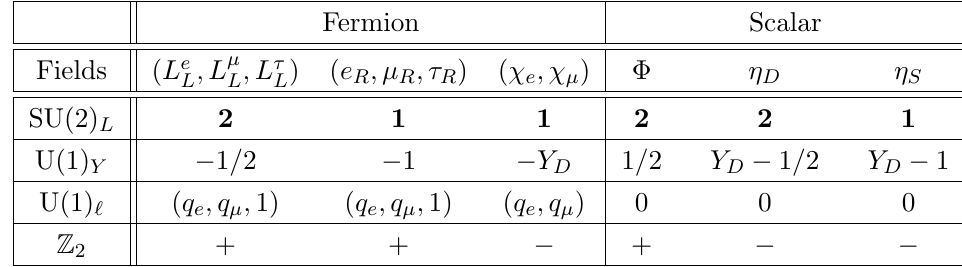
Table 1 . Particle content and charge assignment under the symmetries SU(2) where U(1) ‘ is global. The U(1) ‘ charges depend on the lepton (cid:13)avor with q e Y D appearing in the hypercharges for Z 2 -odd particles can be either 0 or